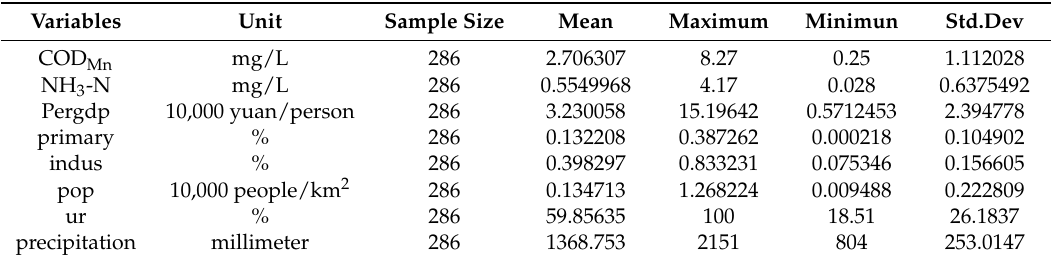
Table 1. Data statistics for water-quality pollutant concentration in 2005–2015 in the Xiangjiang River.